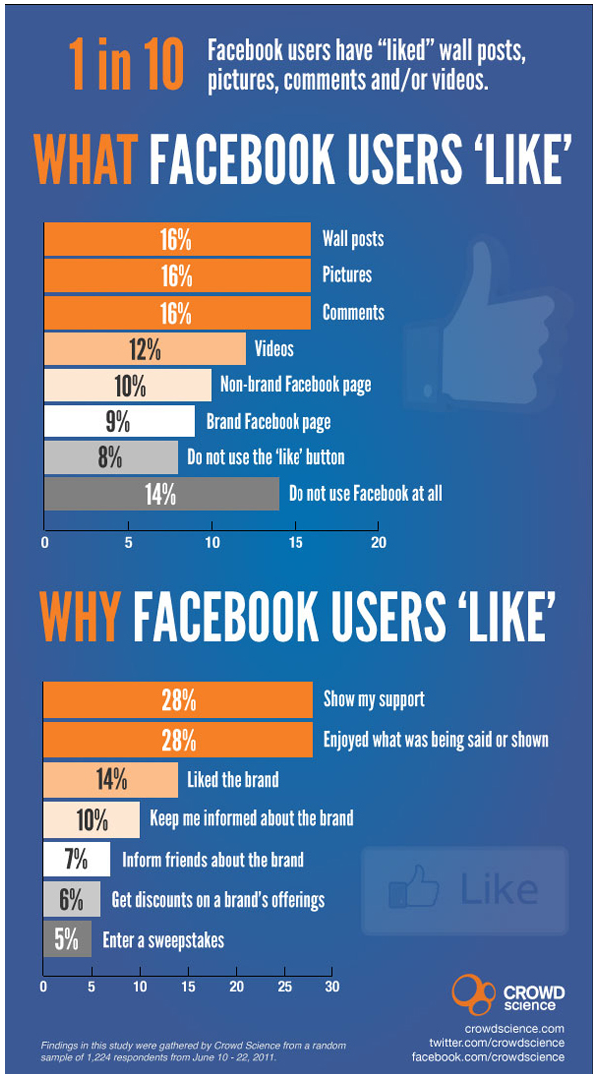
Figure 1. Multimedia and Facebook likes